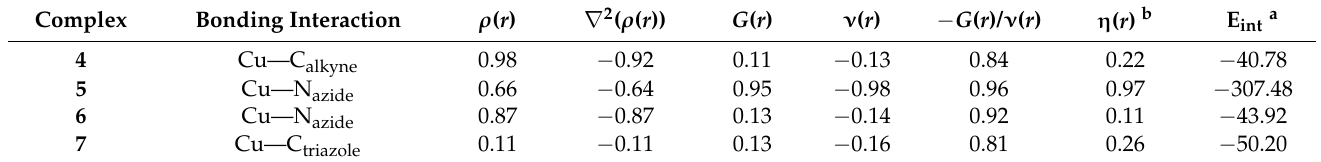
Table 5. Topological parameters of the copper–ligand interaction for the optimized structures of the intermediate complexes at M06-2X/6-311G(d,p) LANL2DZ for